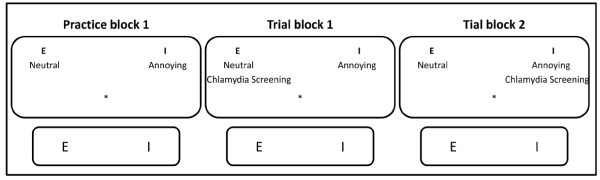
The Single Category Implicit Associations’ Test (SC-IAT). Single Category Implicit Association tests (SC-IATs) are computerized sorting tasks in which, based on reaction times, impulsive preferences are measured. Very simplified in the Figure 1 (three times a computer screen with a keyboard – the ‘E’ and ‘I’-button emphasized), the procedure of a SC-IAT is displayed. The SC-IAT consists of a practice block, and two trial blocks. In a first practice block, participants learn to respond to attribute words (appearing in the center of the computer screen) which have to be categorized in two categories. In this example the attribute categories are ‘neutral’ and ‘annoying’, and are positioned on the left and right side at the top of a computer screen. The attribute words (see Table 1) that appear one by one in the center of the computer screen have to be classified to the attribute categories with either the left (E) or right (I) response key. Participants are to assign the word as fast and accurate as possible to the correct category by pressing the appropriate response key. The assignment of the left key (E) and right key (I) are balanced across participants. The attribute words can be neutral, negative or positive; in this study: annoying, reassuring, and threatening. In the two following blocks, people continue categorizing attribute words, but now the label category ‘Chlamydia screening’ is added to either one of the categories. In block 2, ‘Chlamydia screening’ is combined with ‘neutral’, while in block 3 ‘Chlamydia screening’ is combined with ‘annoying’ and vice versa. If, for example, there is a significant higher mean sorting reaction time when ‘Chlamydia Screening’ is combined with ‘Annoying’ compared to when it is combined with ‘Neutral’, respondents have an impulsive negative reactance towards Chlamydia screening; they associate Chlamydia screening more with the attribute annoying than with a neutral attribute.